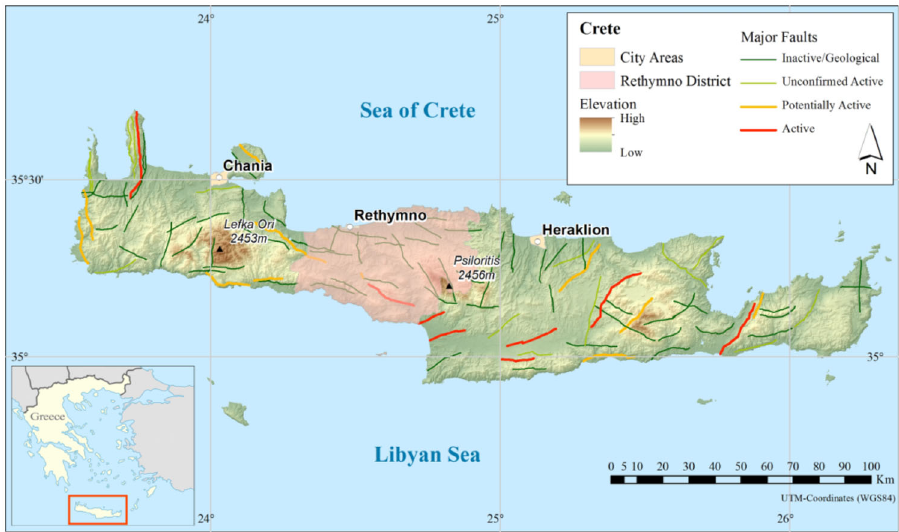
Fig. 3 Topographical map of Crete Island Rethymno District and its surroundings. The DEM (digital elevation model) indicates the variation of the terrain landforms expanding through the whole island. Four different categories of faults have been identified, two of which (active and potential active faults) have been correlated with the mainland seismic activity of the island.